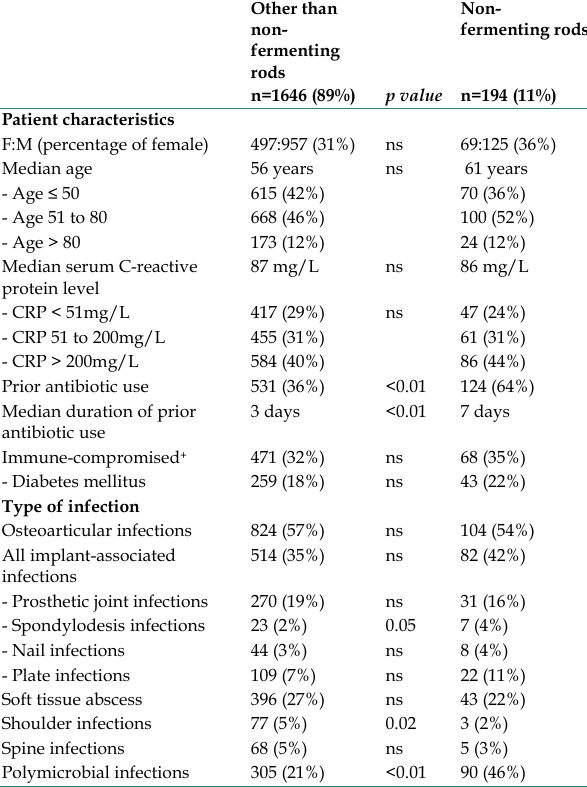
Table 2 . Comparison of orthopedic infections due to Gram- negative non-fermenting rods versus other pathogens.